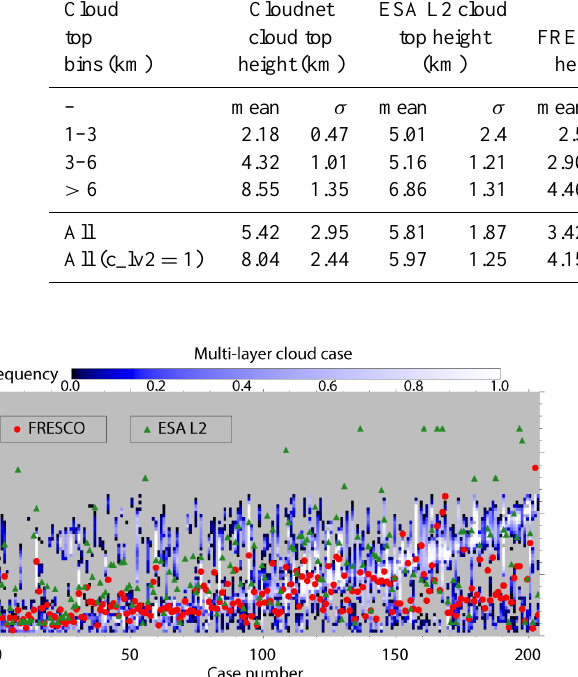
Table 3. Comparison of SCIAMACHY cloud (top) heights with Cloudnet cloud (top) height for selected single-layer clouds. Here, the ESA L2 cloud top height retrievals are fully converged. Cloud fractions derived from the Cloudnet data are 1. The effective cloud fraction is > 0.1. “All (c_lv2 = 1)” has an additional selection criterion of an ESA L2 cloud fraction of 1. Cloud Cloudnet ESA L2 cloud Cloudnet ESA L2 Cloud top cloud top top height FRESCO cloud cloud middle optical No. of height (km) thickness